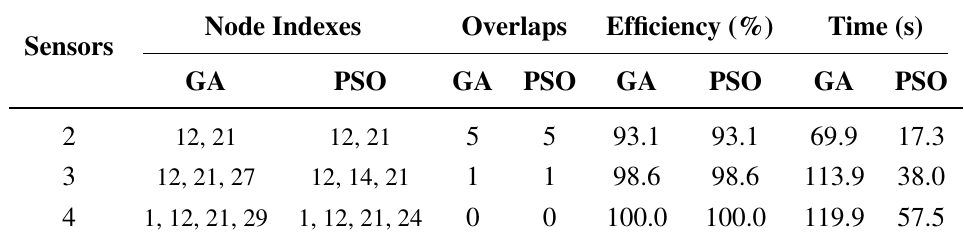
Table 3. Sensor placement in the Hanoi WDN using stochastic approaches and a single time instant.